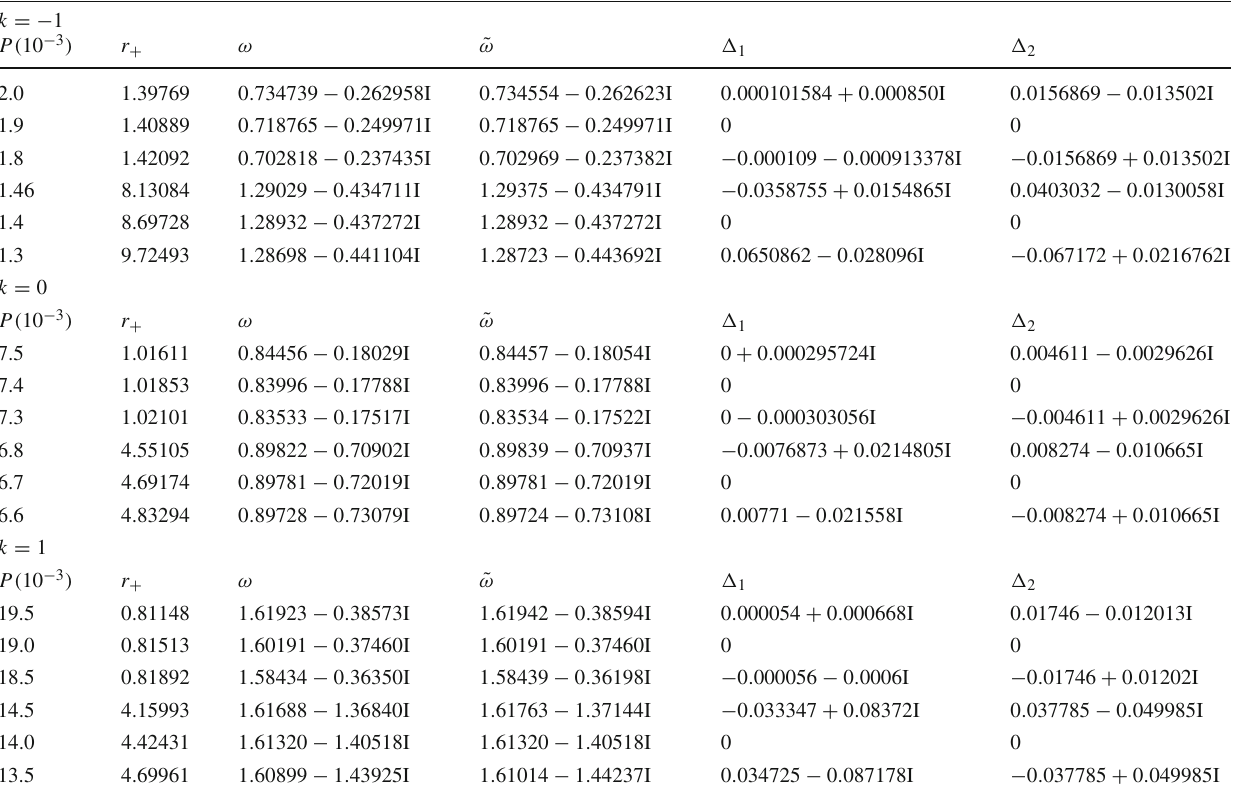
Table 5 ˜ ω is the QNM frequencies from the linear approximation. (cid:16) 1 and (cid:16) 2 represent corrections due to variation of the black hole size and pressure,